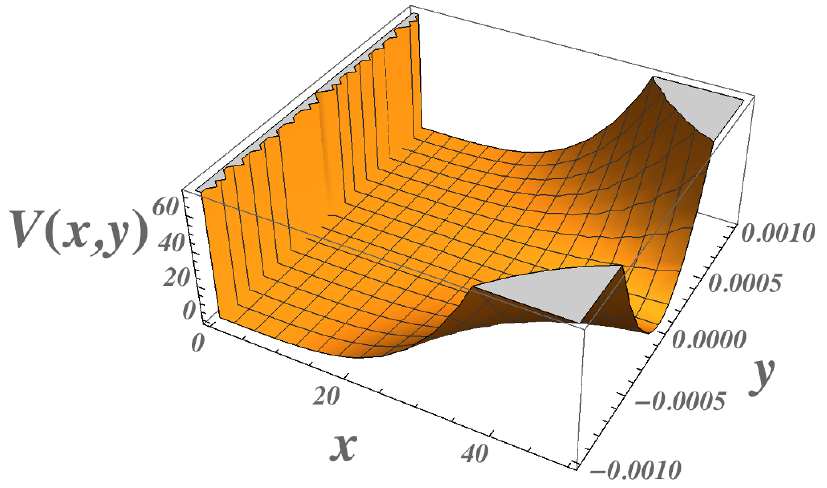
Figure 1 . The potential V ( x; y ) for a = b = (cid:11) = 1 in no-scale supergravity with the stabilized K(cid:127)ahler potential (2.21) and the superpotential